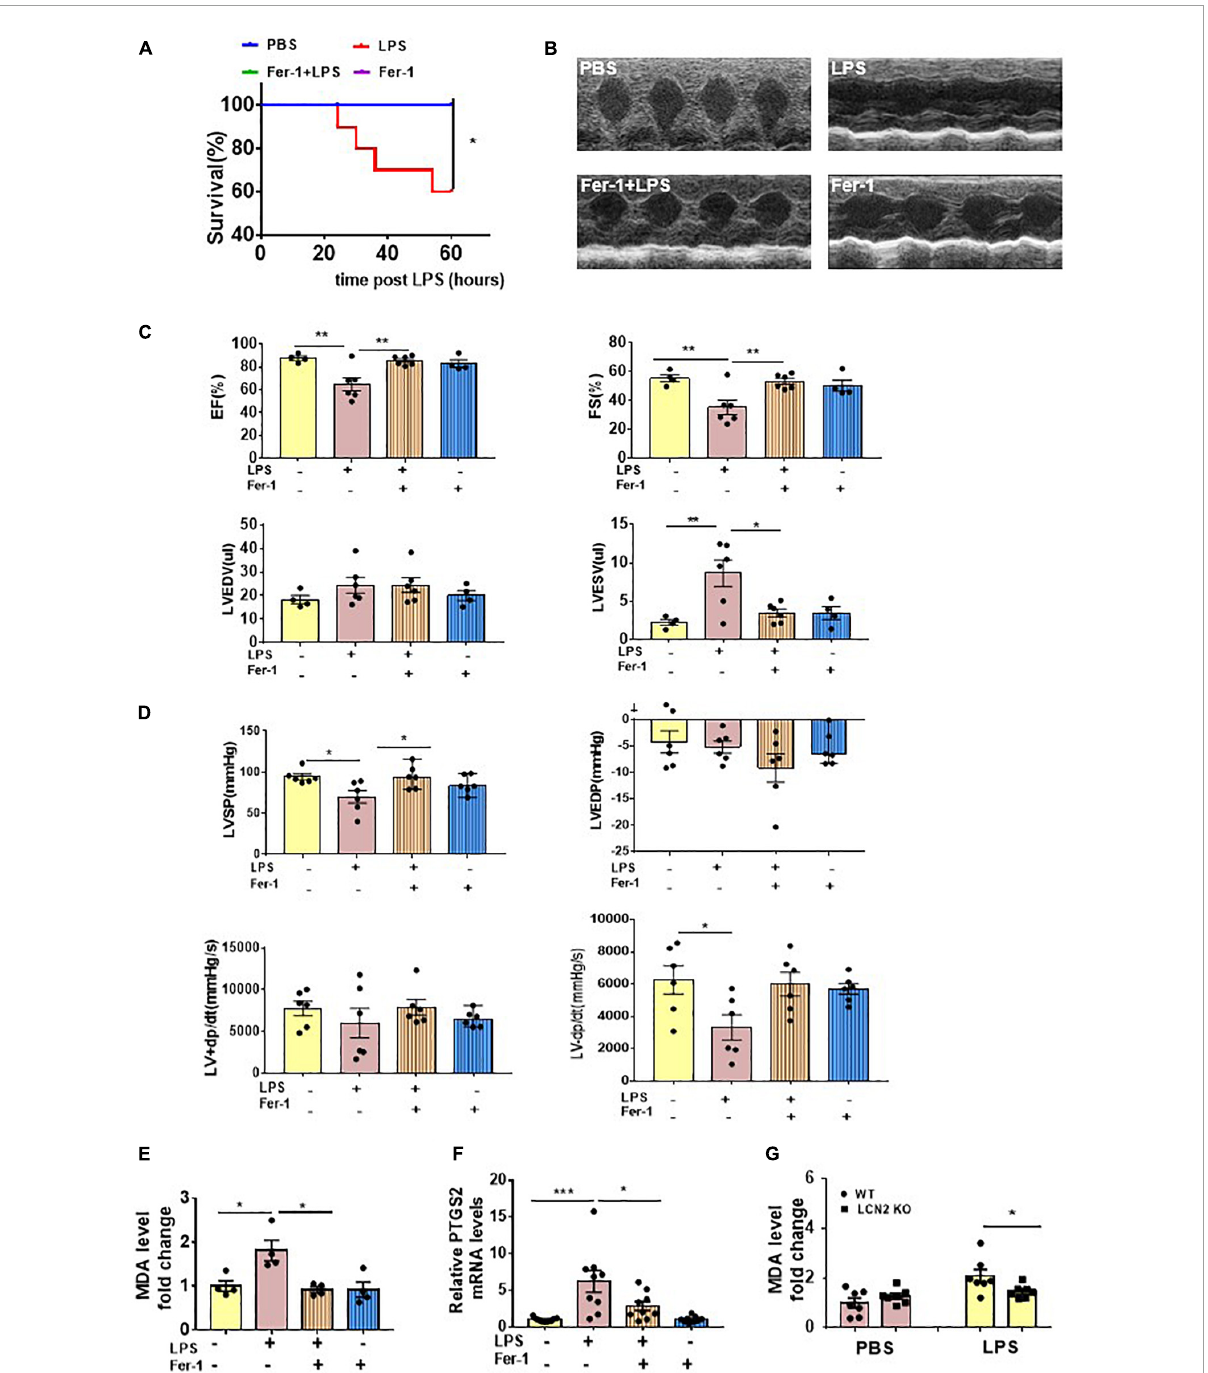
FIGURE5 Ferroptosis presented in LPS-induced SCD mice. (A) Survival curve of WT mice intraperitoneally injected with either PBS or Fer-1 (1 mg/kg) at 24 h, 2 h before LPS (25 mg/kg, n = 10 in each group) administration. (B,C) Echocardiography was performed in WT mice intraperitoneally injected with either PBS or Fer-1 (1 mg/kg) at 24 h, 2 h followed by LPS (25 mg/kg) or PBS administration for 12 h ( n = 4, 6, 6, 4, respectively). (D) Invasive hemodynamics was monitored in WT mice intraperitoneally injected with either PBS or Fer-1 (1 mg/kg) at 24 h, 2 h followed by LPS (25 mg/kg) or PBS administration for 12 h ( n = 6 in each group). (E) Cardiac MDA levels were detected in WT mice intraperitoneally injected with either PBS or Fer-1 (1 mg/kg) at 24 h, 2 h followed by LPS (25 mg/kg) or PBS administration for 12 h ( n = 4 in each group). (F) Cardiac PTGS2 mRNA expressions were determined by qPCR in WT mice intraperitoneally injected with either PBS or Fer-1 (1 mg/kg) at 24 h, 2 h followed by LPS (25 mg/kg) or PBS administration for 12 h ( n = 9 in each group). (G) Cardiac MDA levels were detected in LCN2 KO mice and their WT littermates 12 h after intraperitoneal injection of either PBS or LPS (25 mg/kg) ( n = 7 in each group). * p < 0.05, ** p < 0.01, *** p <